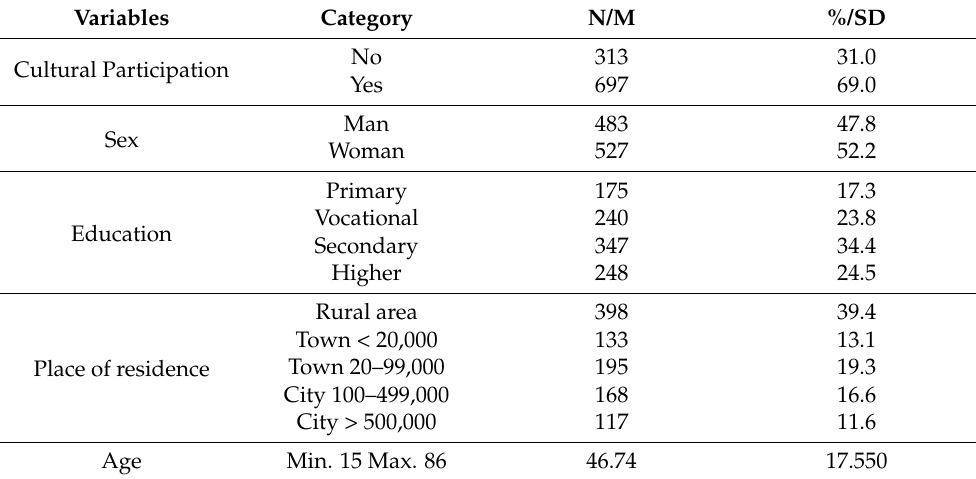
Table 1. The results of summary